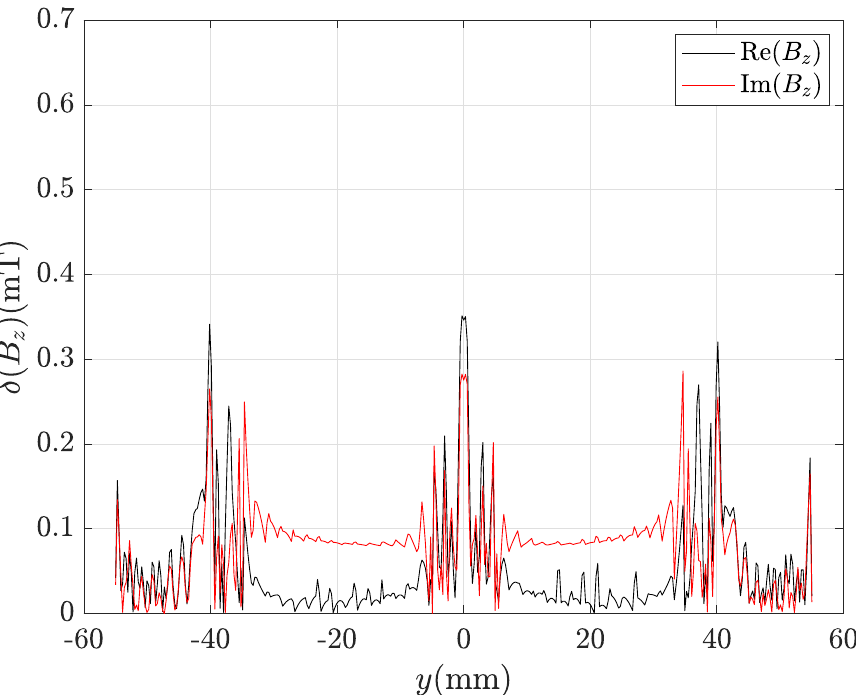
Figure 14. computed byLocal discrepancy between CM-BEM and FEM profiles of component B z in Figure 12.